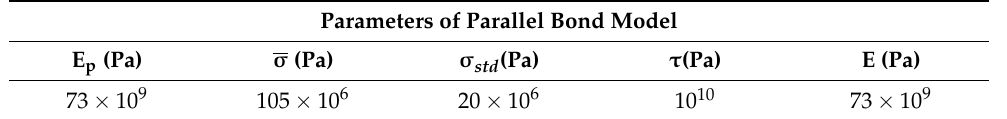
Table 4. Parameters of parallel bond model of the 3D sample. E, E p , σ , σ std , τ are the contact effective modulus, parallel bond effective modulus, parallel bond mean tensile strength, parallel bond tensile strength standard deviation, and parallel bond shear